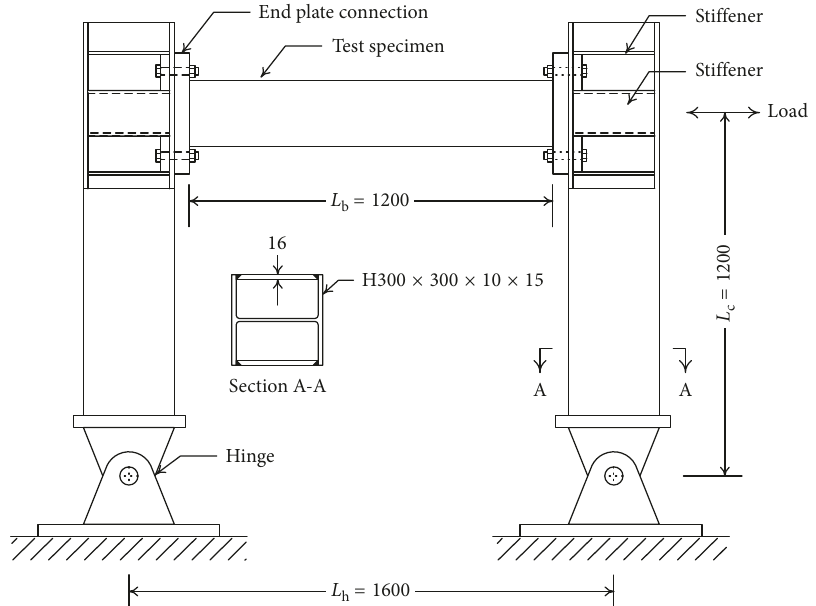
Figure 3: The test scheme for beam specimens (unit: mm); adapted from “The Effect of Intermediate Stiffeners on Steel Reinforced Concrete Beam Behaviors”